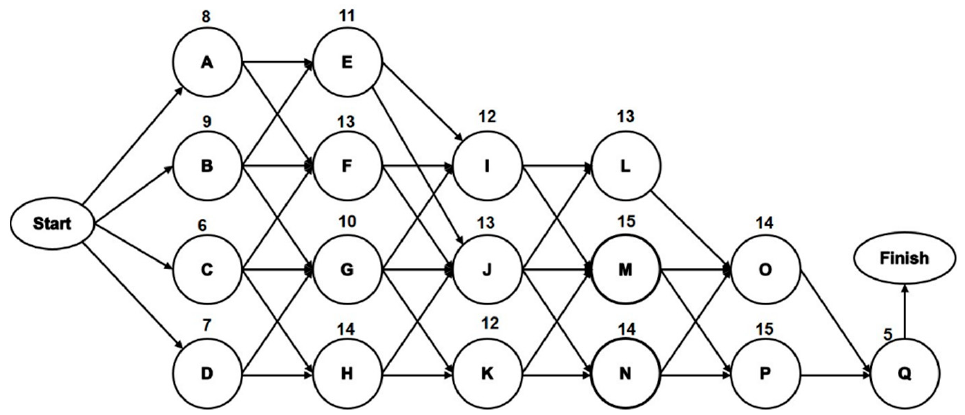
Figure 4. Network Diagram for Project C.